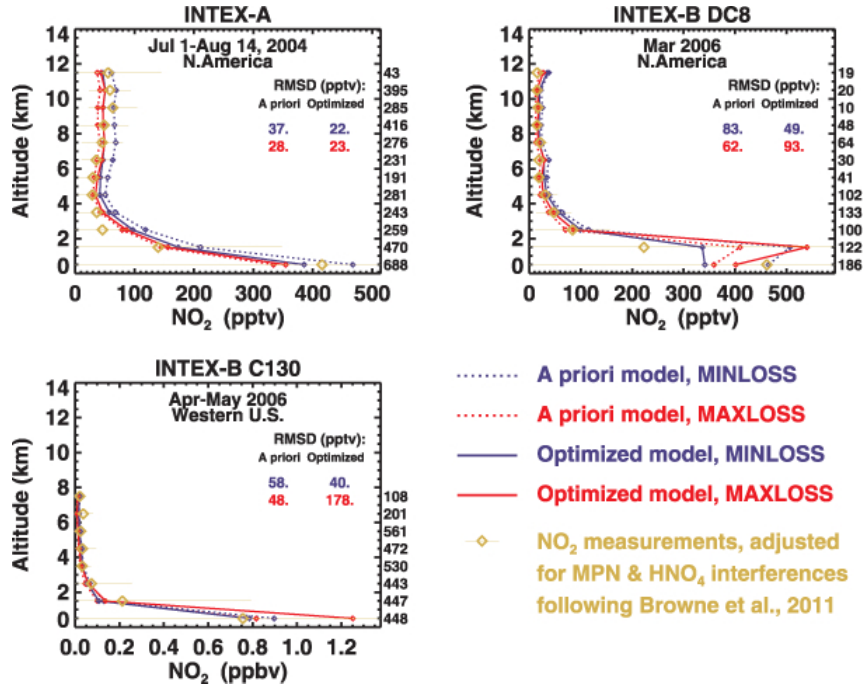
Fig. 11. A priori and optimized modelled NO 2 mixing ratios compared with observed mean mixing ratios during the INTEX-A and INTEX- B missions over North America. Note that the real measurement altitudes are taken into account when deriving the model averages. Observed NO 2 mixing ratios are adjusted for methyl peroxy nitrate (MPN) and HNO 4 interferences according to Browne et al. (2011).